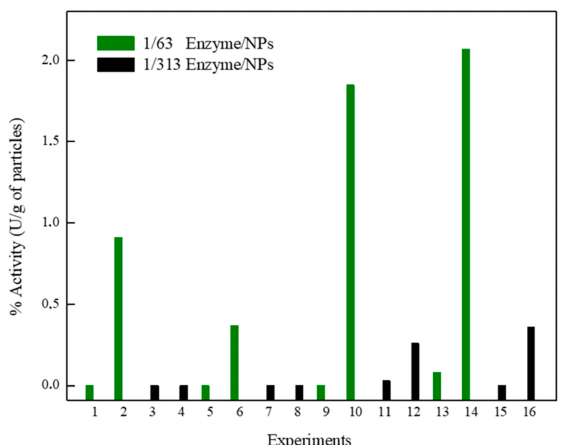
Figure 6. Activity (U / g of nanoparticles) of immobilized HRP on ferroxyte ∆ -FeOOH under di ff erent processes conditions: pH 4.0 (odd-number experiments), pH 8.0 (even-number experiments), and temperature 25 ◦ C (experiments 1 until 8) and 60 ◦ C (experiments 9 until